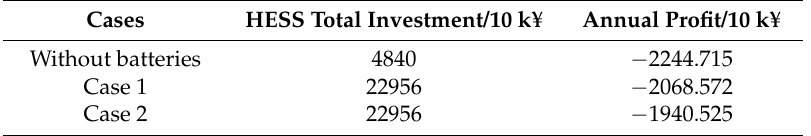
Table 4. Economic comparison.